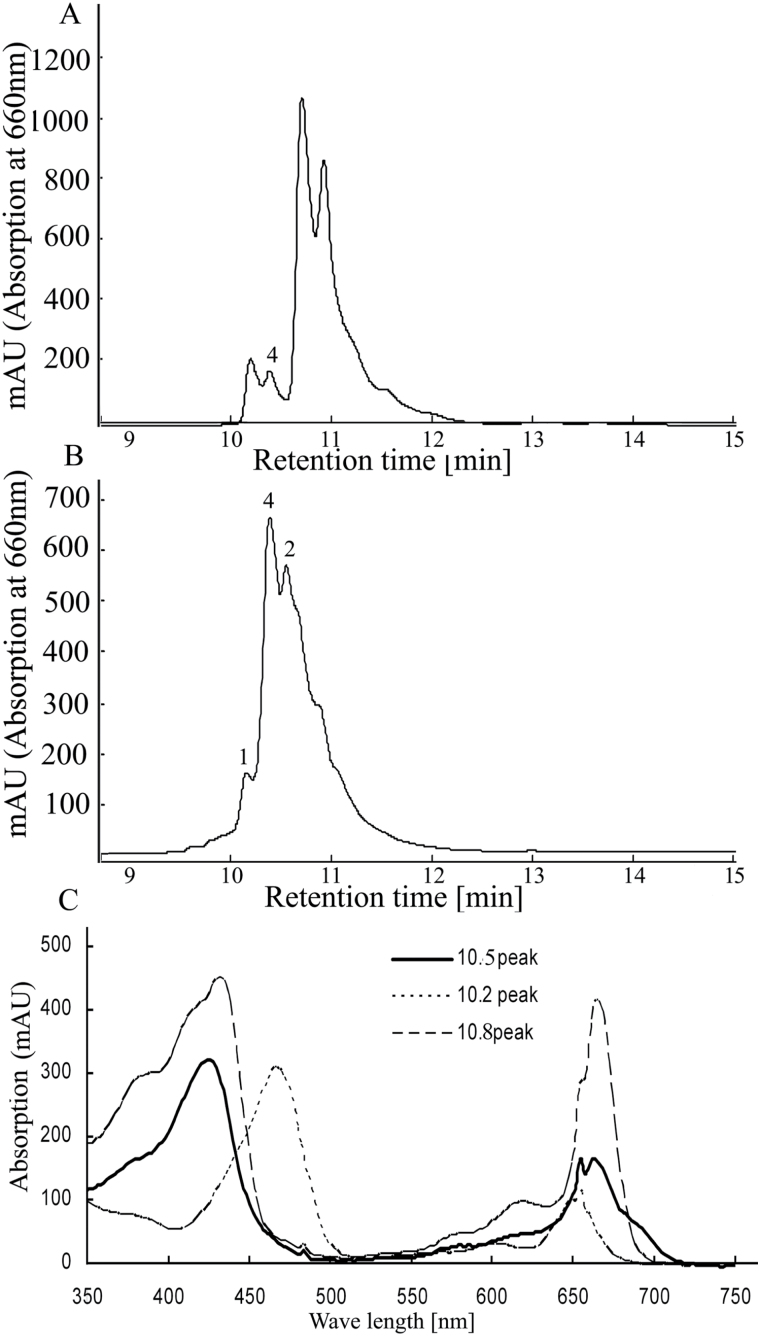
HPLC profile of the authentic 7-hydroxymethyl chlorophyll prepared from leaf chlorophyll extract of N22 in (A) 8-hydroxyquinoline (8-HQ) and methanol; and (B) 8-HQ, methanol, and NaBH4. (C) Absorption spectra of the peaks with retention times 10.2, 10.8, and 10.5min observed in the HPLC profiles.